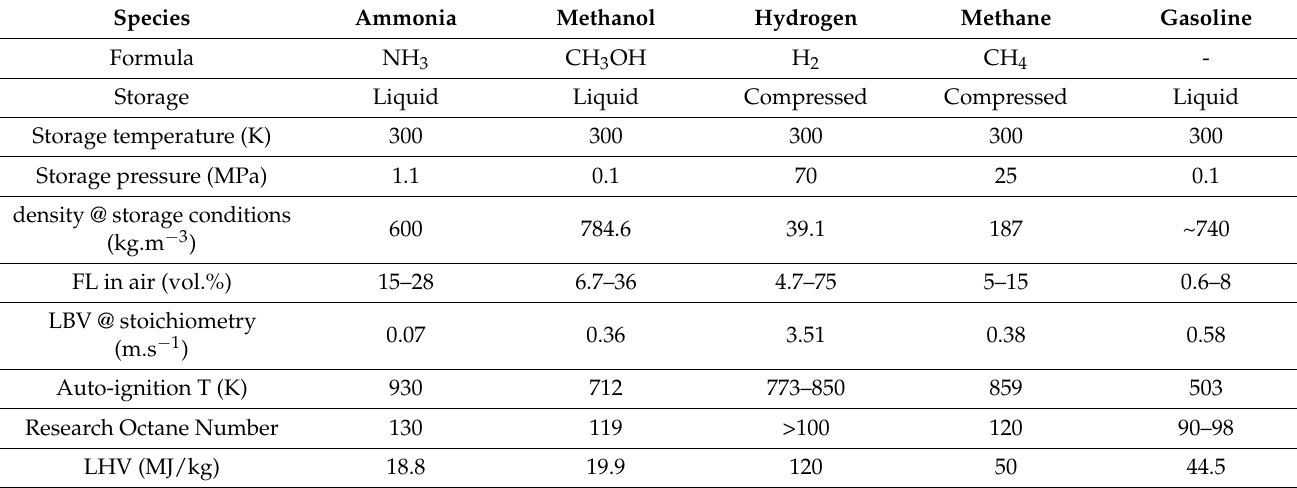
Table 1. Ammonia properties and comparison with other fuels at 300 K and 0.1 MPa, unless stated otherwise.